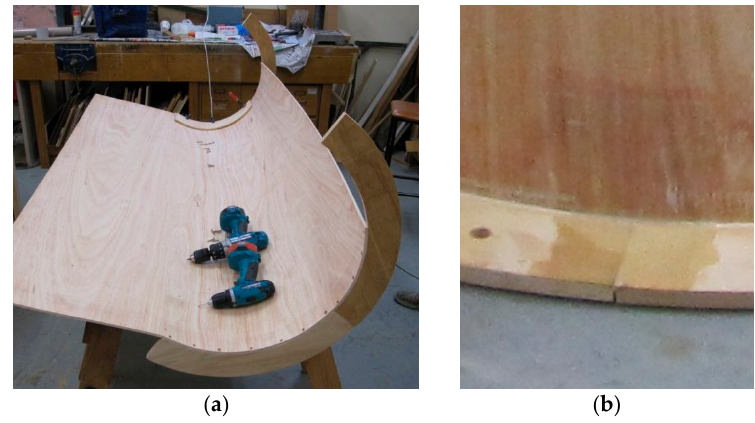
Figure 3. ( a ) A sheet of 6 mm bendy ply; ( b ) Flange joint with 200 g woven cloth reinforcement.